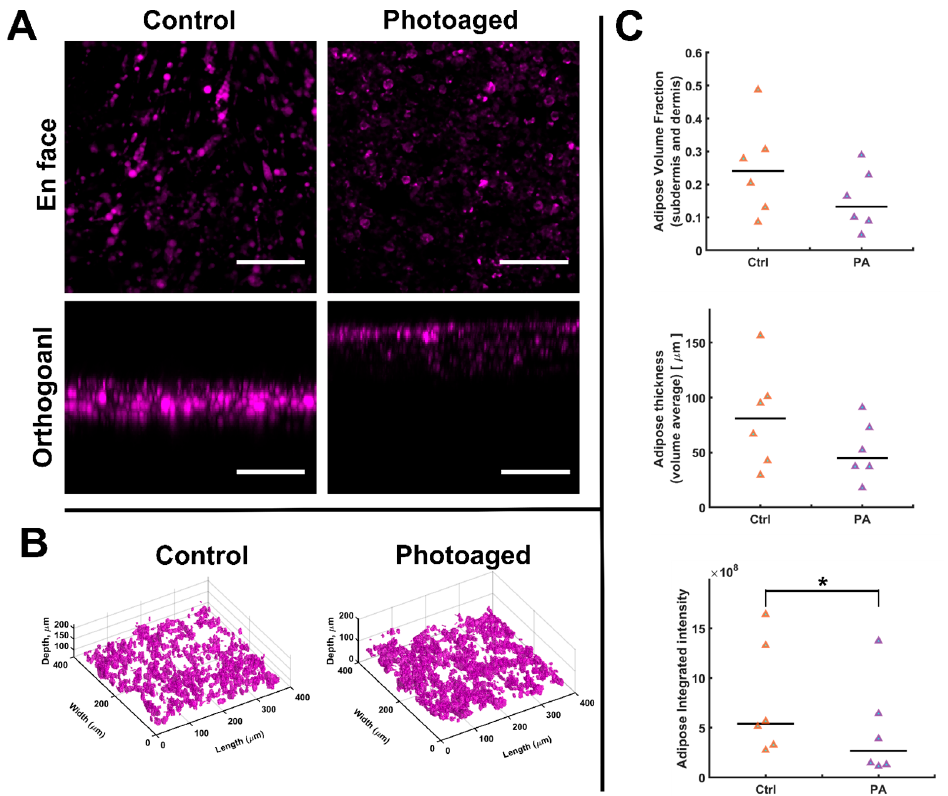
Figure 6. Adipose staining and quantification. ( A ) A comparison of confocal images of control vs. photoaged AVHSE sub-dermis; BODIPY marks lipid accumulation at mature adipocytes in magenta. Scalebars are 100 µm. ( B ) Representative 3D rendering of adipose volume fraction for control and photoaged samples. ( C ) Top-Volume Fraction was calculated based on segmentation of the BODIPY stain as seen in B. Middle-Thickness quantification based on morphological closing of BODIPY segmentation. Bottom-Integrated Intensity of BODIPY across the volume shows a significant ( p < 0.05; indicated with *) drop in photoaged samples ( n = 6 for each condition). Data is shown as medians (black bars) and individual data points (triangles). Images were acquired pre-clearing and are median filtered for clarity.